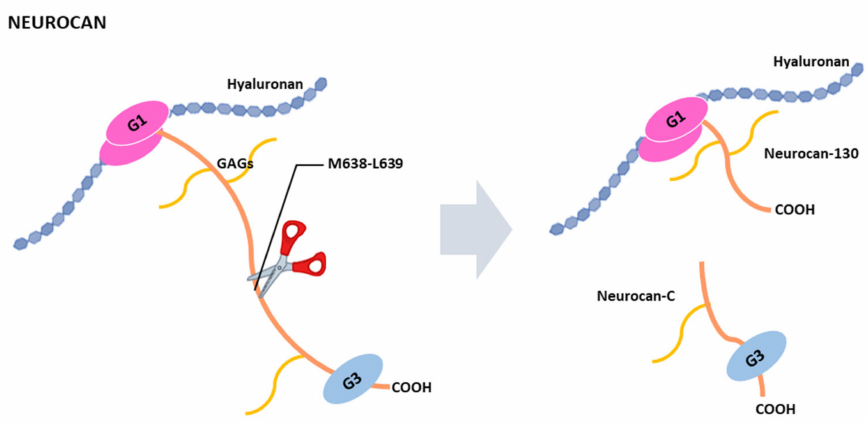
Figure 6. Schematic representation of neurocan proteolysis. Neurocan is cleaved at M638-L639 to generate two fragments, neurocan 130 and neurocan-C, corresponding to the NH 2 -terminal and COOH-terminal ends of the original undigested neurocan. G1 and G3 indicate globular domains. Other cleavage sites are indicated in the